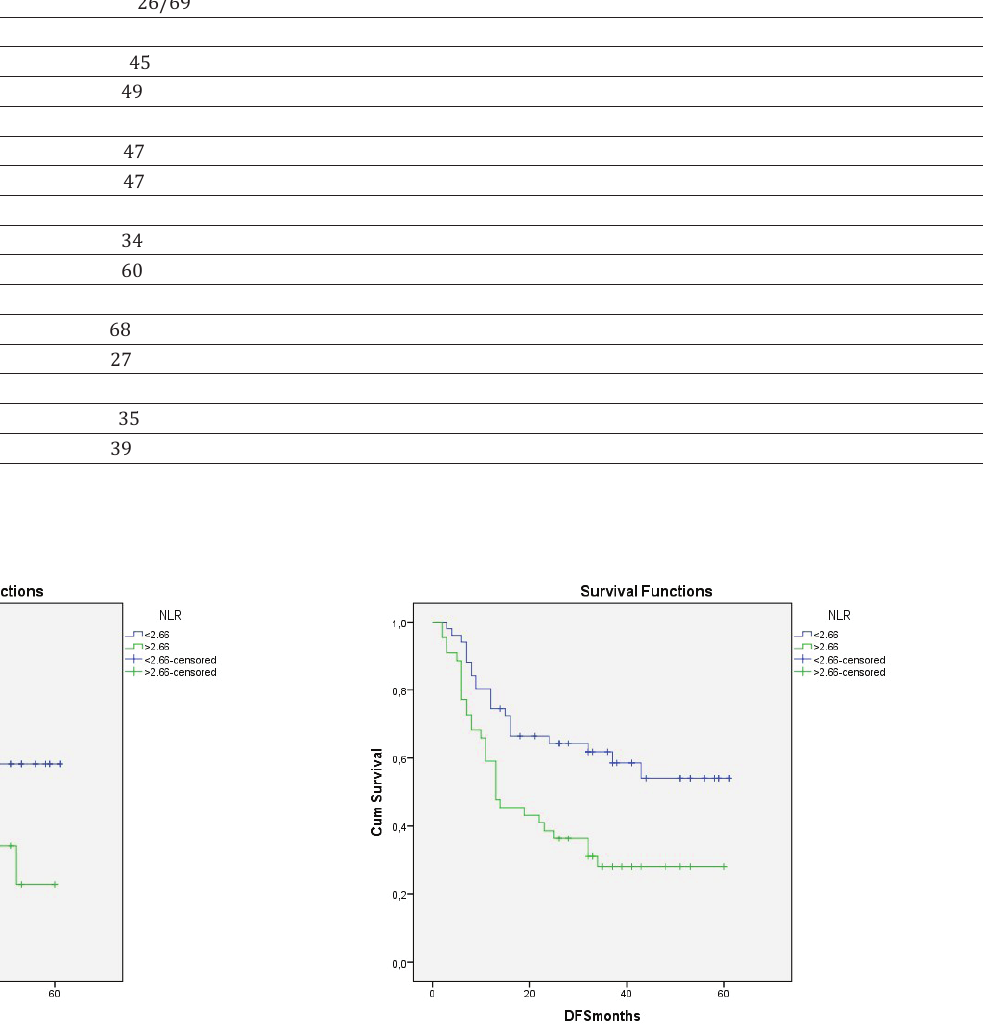
Figure 1b - Kaplan –Meier curvefordisease-free survival of low and high neutrophil-lymphocyte